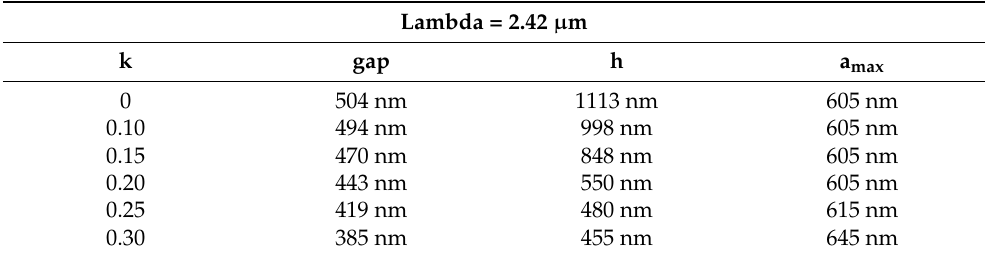
Table 2. Measurement data when λ = 2.42 µ